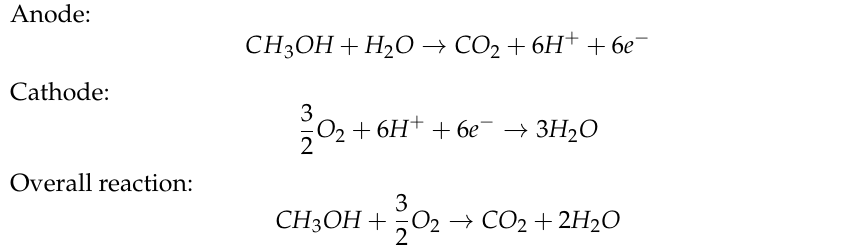
Figure 4. Schematic diagram of the working principle of a